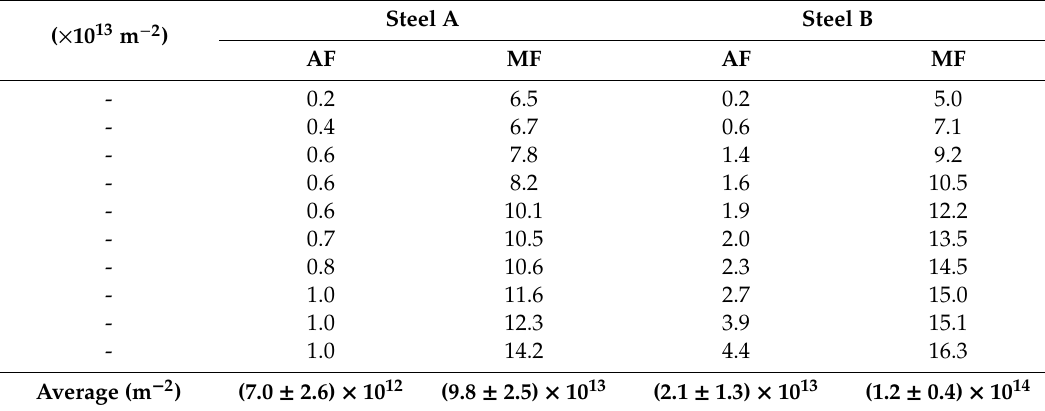
Table 2. The dislocation density